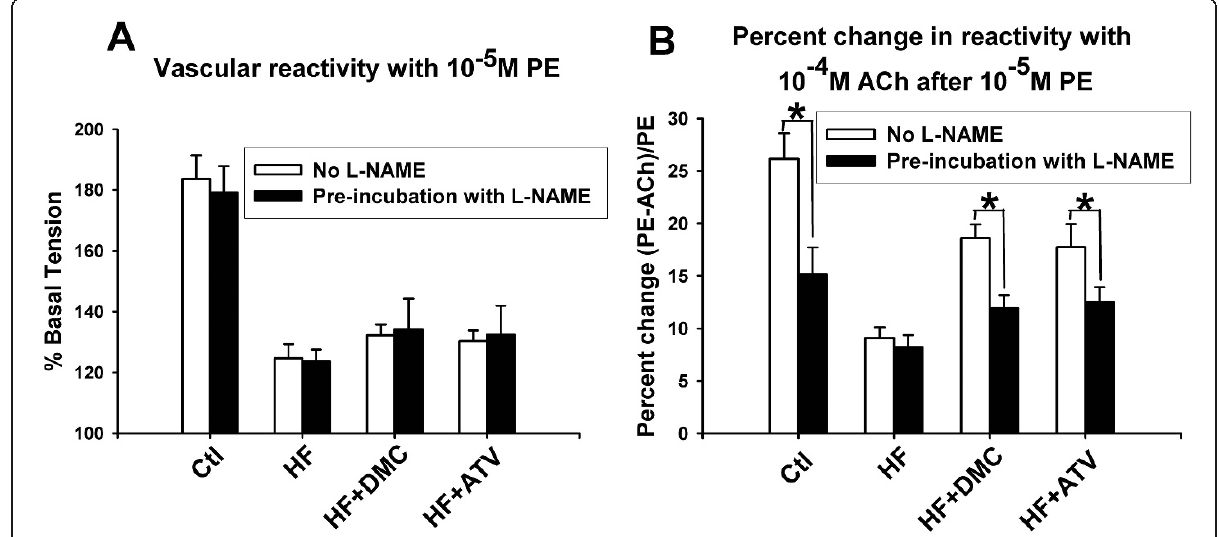
Figure 3 Effect of eNOS on the relaxation of aortic rings . ( A ) The contraction of aortic rings with 10 -5 M PE before and after pre-incubation of L-NAME, 10 -4 M, eNOS inhibitor. ( B ) The percent change in relaxation (tension PE - tension ACh/tension PE) to 10 -4 M ACh after 10 -5 M PE before and after pre-incubation of L-NAME. Data presented as mean ± S.E.M. and expressed as percentage of baseline tension. * P < 0.01 vs. relaxation value of corresponding group before pre-incubation of L-NAME, n = 8-10 rings from 5-6